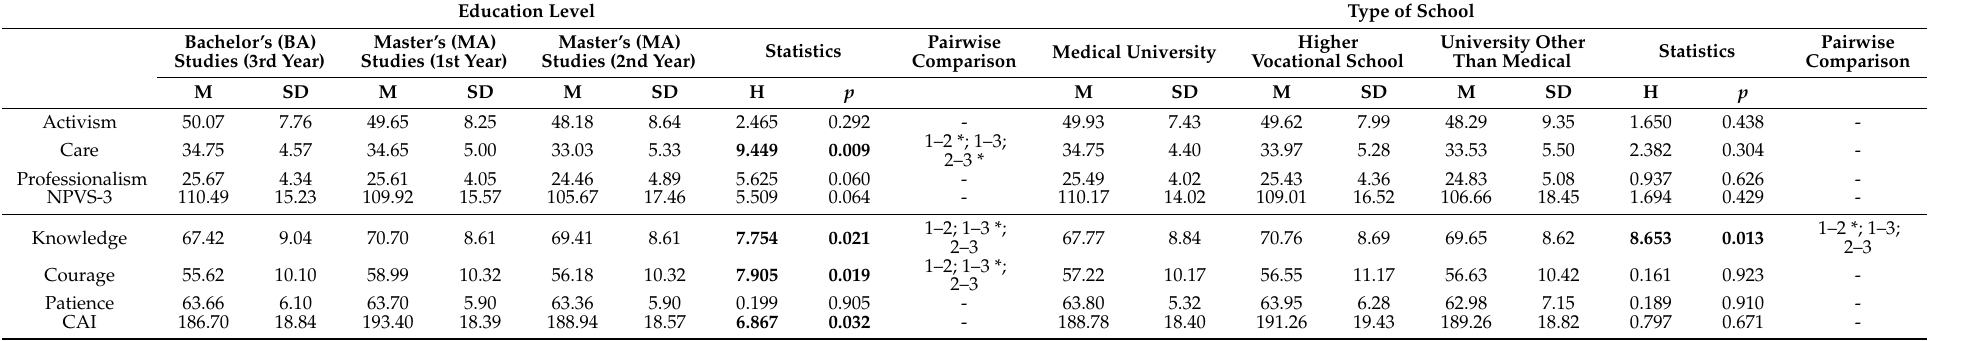
Table 5. Relationship between the year and place of study and NPVS-3 and CAI.